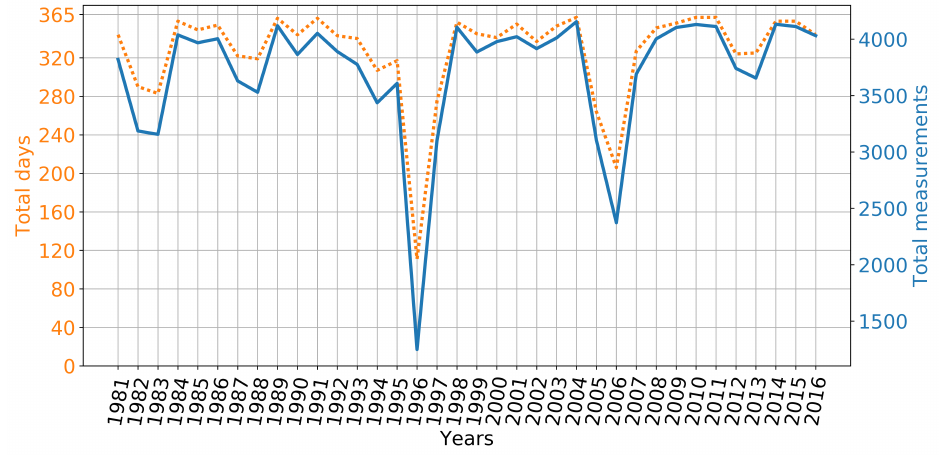
Figure 1. Number of annual total available days (orange dotted line) and number of annual total available GHI measurements (blue line) for the entire period